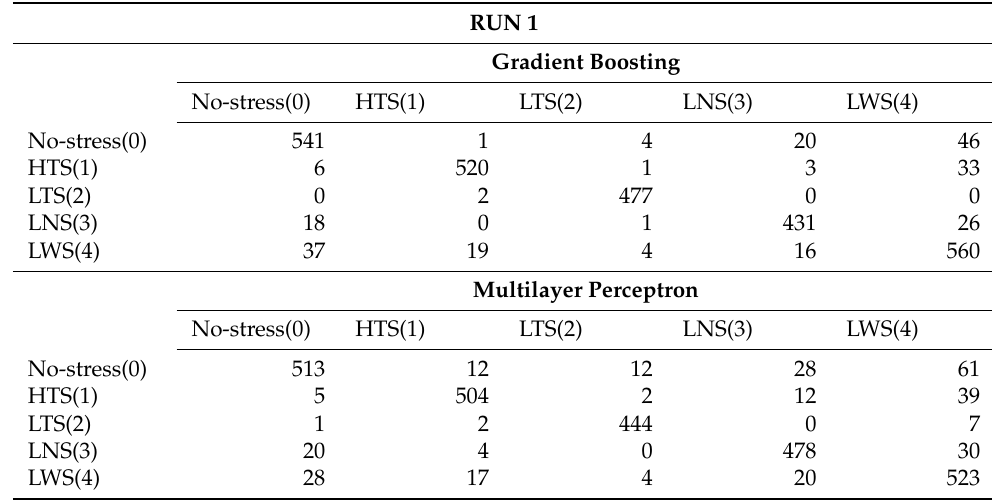
Table 1. The predicted category of the samples of each treatment for GB and MLP algorithm in the RUN 1 test process (of testing sample 2765).